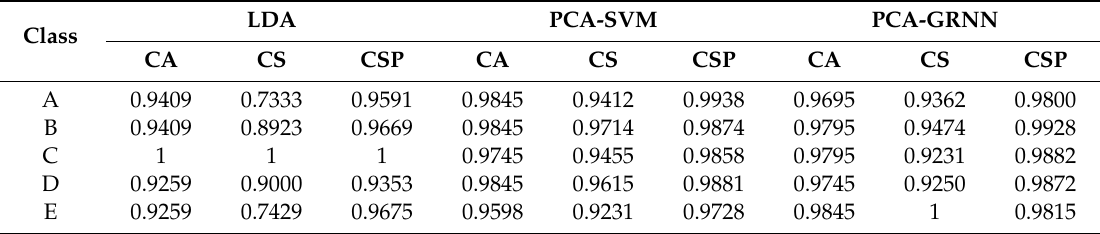
Table 5. Predictive performances of three multi-category classification models for five granulation levels in the prediction set.